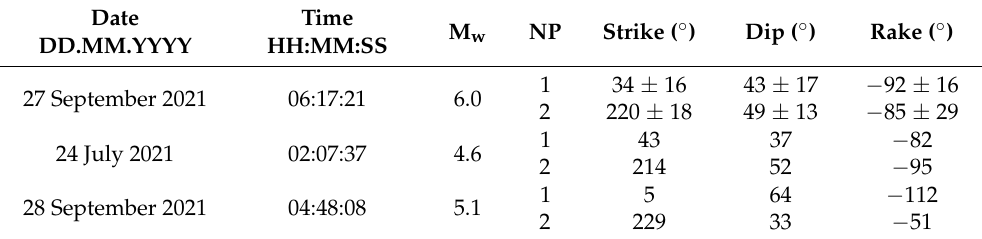
Table 2. Average (A v ) geometric features of the nodal planes (NP) determined for the mainshock of 27 September 2021 in 10 fault-plane solutions produced by several national and international seismological centers (see https://www.emsc-csem.org/Earthquake/index_tensors.php, last access 17 December 2021). Average NP geometric features have been also determined for the largest foreshock and the largest aftershock but only from two